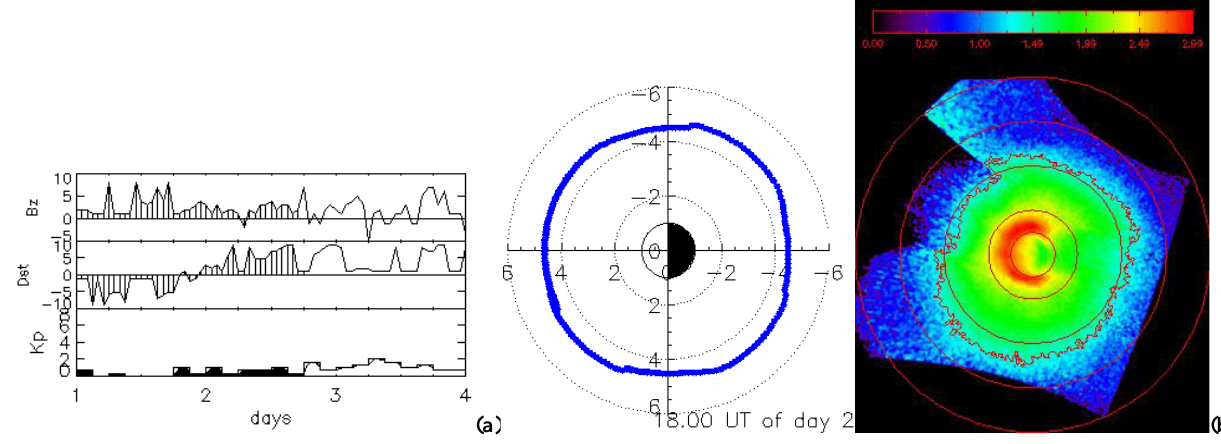
(right panel (b), EUV observation).